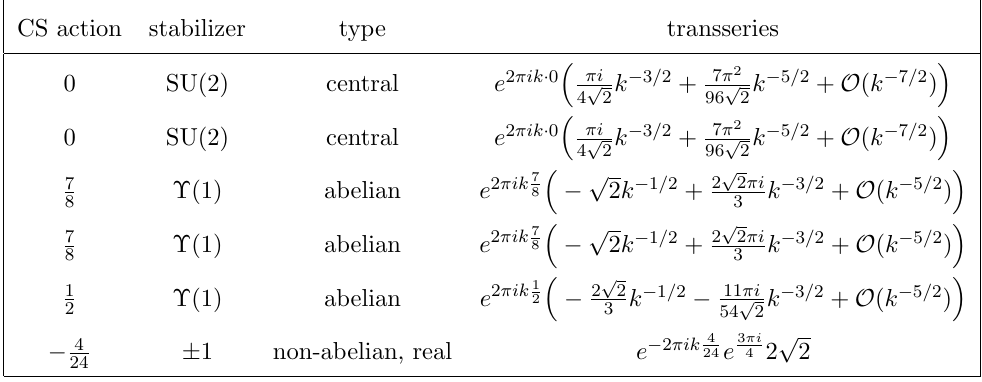
Table 5 . Transseries for M (